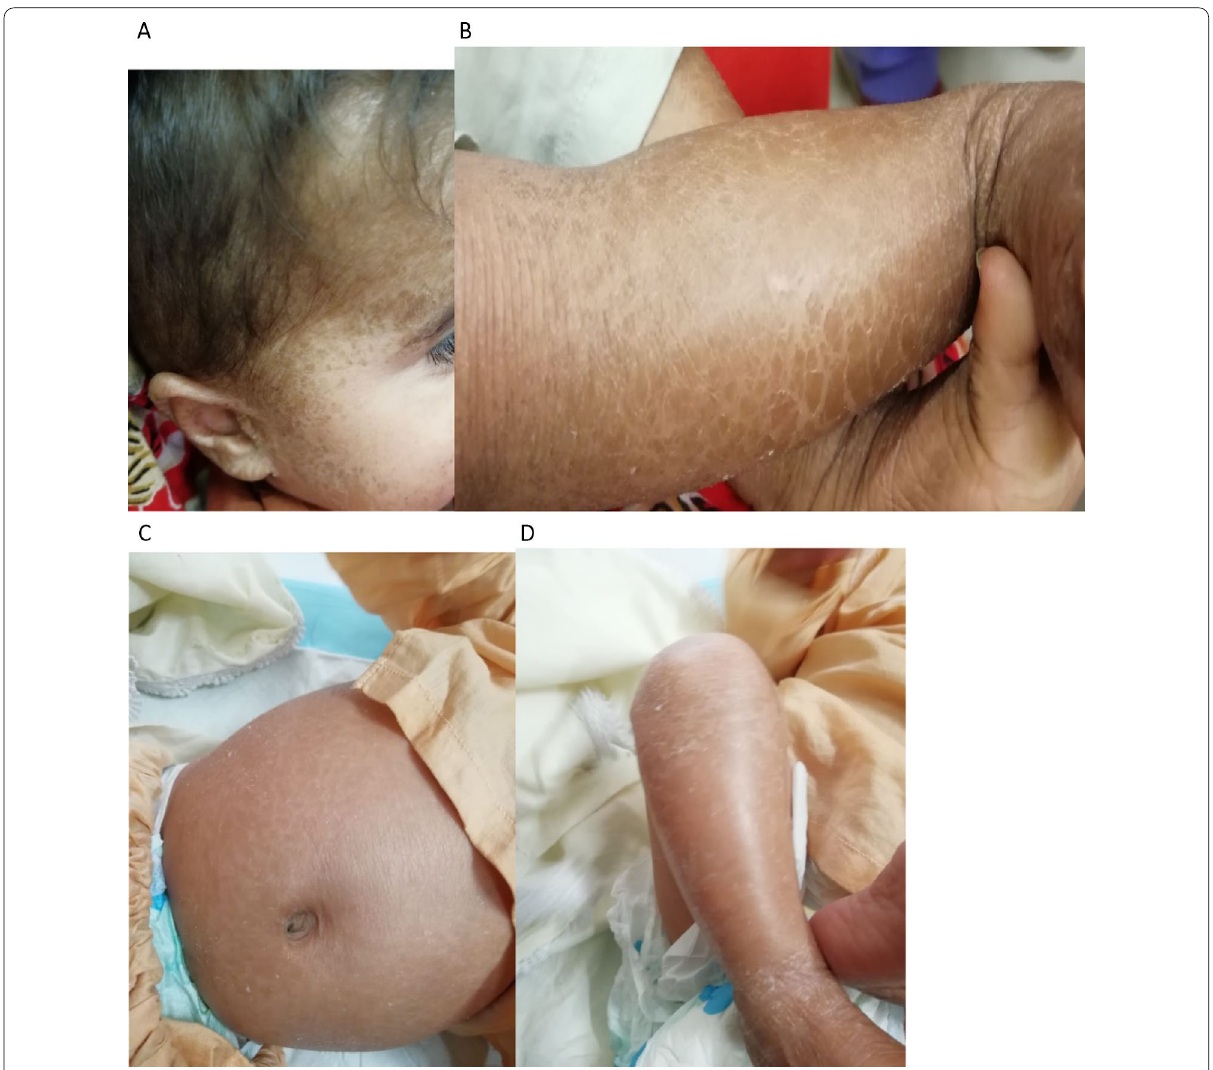
Fig. 3 Dermatological characterization of CDS patients. Lamellar ichthyosis affecting facial region, trunk and extremities of Case 3 ( a , b ), Case 5 ( c , d